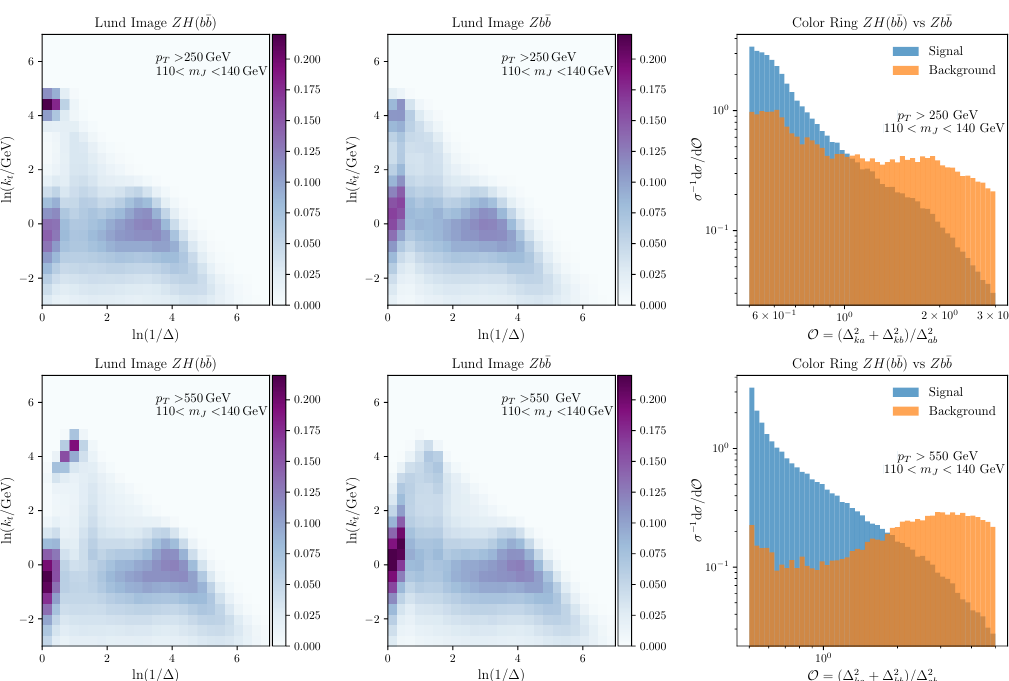
Figure 1: The averaged primary Lund jet plane images and the jet color ring distri- > 250 GeV and 550 GeV benchmarks of H → b ¯ b analysis. Figures butions for the p T are taken from Ref [ 3 ] under the Creative Commons Attribution 4.0 International